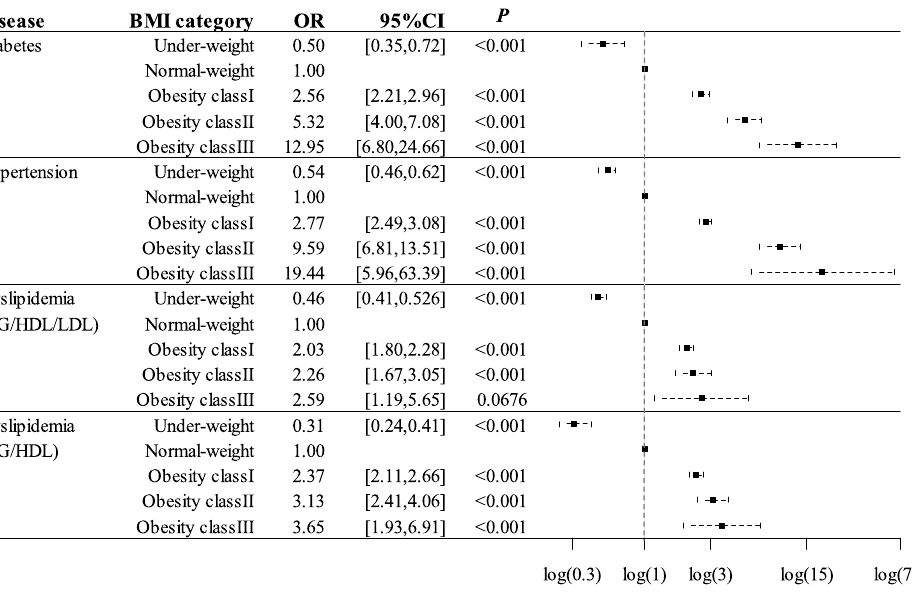
Figure 3. Adjusted OR and its 95% CI for diabetes, hypertension, and dyslipidemia in participants of each BMI category with normal weight as the reference. Each OR was adjusted for sex, smoking status, and exercise habit. The horizontal axis represents the log-transformed adjusted OR. P -values were calculated in the comparison of the OR for each disease between normal-weight group (reference) and other groups by adjusting for multiplicity by Bonferroni’s correction. Dyslipidemia (TG/HDL/LDL) and dyslipidemia (TG/HDL) were defined in the